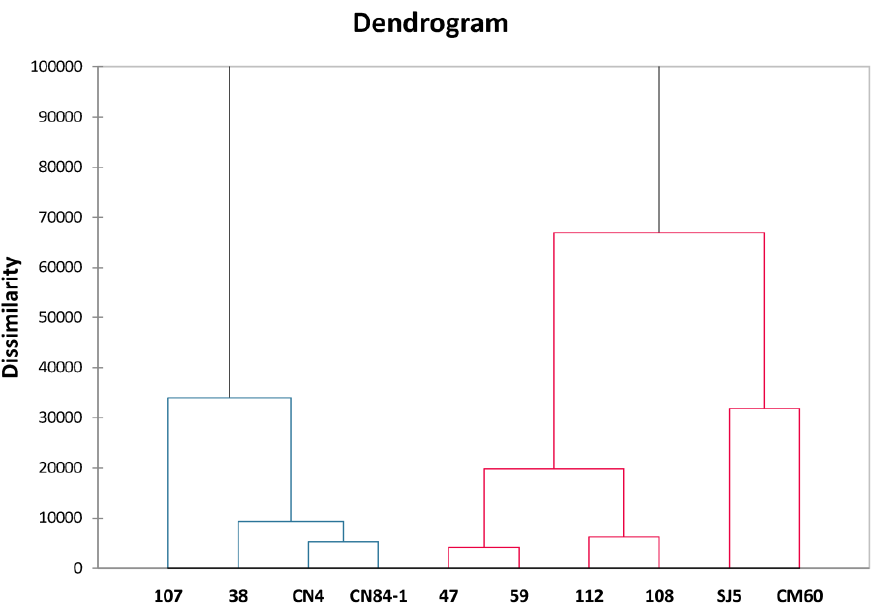
Figure 3. The dendrogram obtained from the mean values (proximate compositions, vitamins, and minerals), total phenolic contents (TPCs), and antioxidant activities as being determined by oxygen